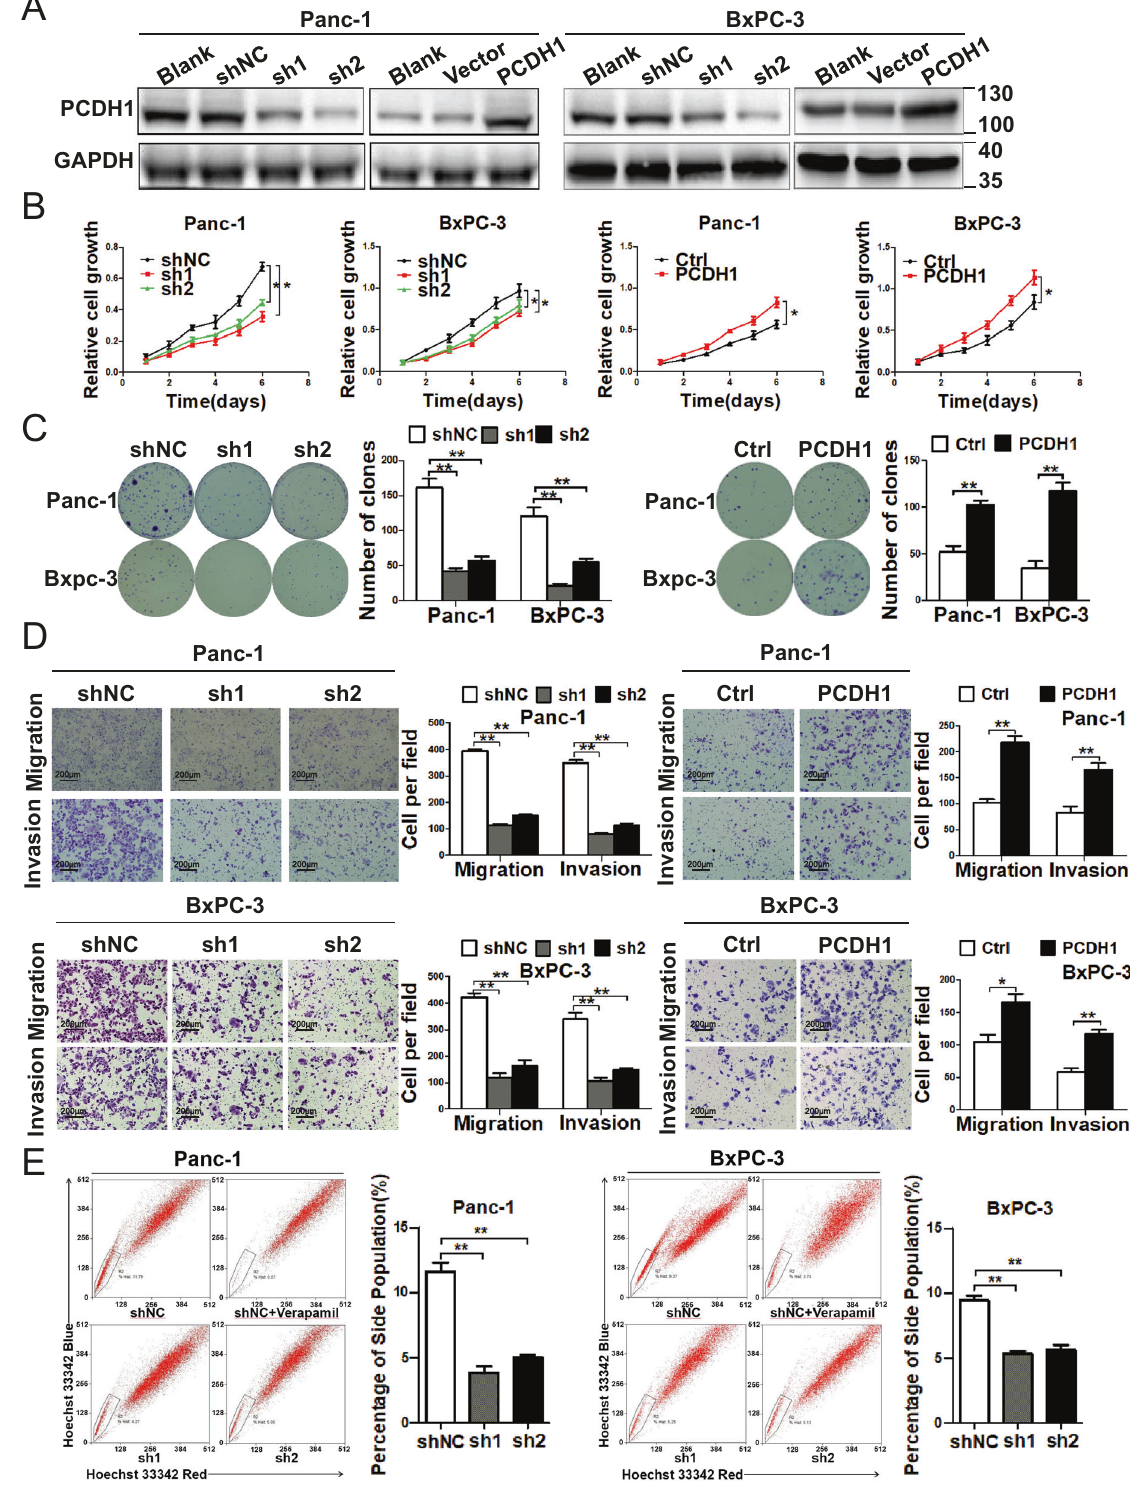
Fig. 2 PCDH1 promotes the growth, metastasis and side population phenotype acquisition of PDAC cells in vitro. A Knockdown ef fi ciency and enforced expression of PCDH1 in PDAC cell lines was evaluated by Western blotting. B An MTT assay was performed to detect the effect of PCDH1 on the proliferation of PDAC cell lines. C Representative images showing the effects of PCDH1 expression knockdown (left) or overexpression (right) on colony formation. The number of colonies containing more than 50 cells was counted. D The effects of PCDH1 knockdown (left) or overexpression (right) on migration and invasion were evaluated by Transwell assays. E Representative images showing the effects of PCDH1 knockdown on SP phenotype acquisition. The results are presented as the mean ± SD of three independent experiments. The data were assessed by Student ’ s 2-tailed t test. * P < 0.05, ** P <